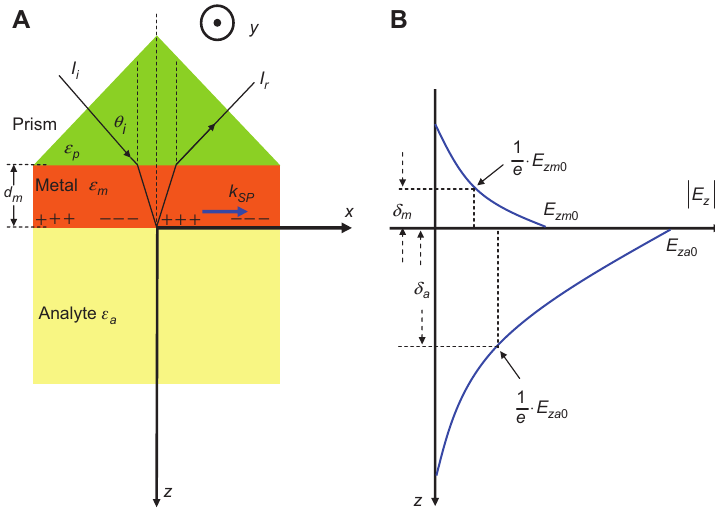
Figure 2 (A) Schematic illustrations to the longitudinal charge density generated at the metal\dielectric interface in the Kretschmann con- fi guration. (B) Enhancing the fi eld component perpendicular to the interface due to the surface charge. δ perpendicular to the surface in the metal and the dielectric regions respectively. ε d is the metal layer m